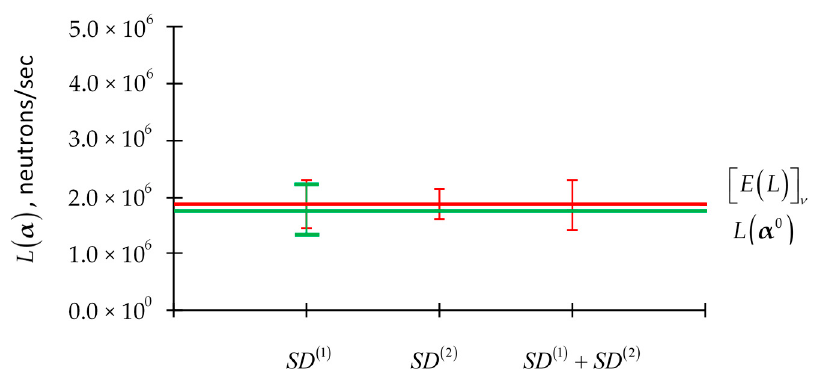
Figure 18. Comparison of red), due to 10% standard deviations of the uncorrelated isotopic number densities.